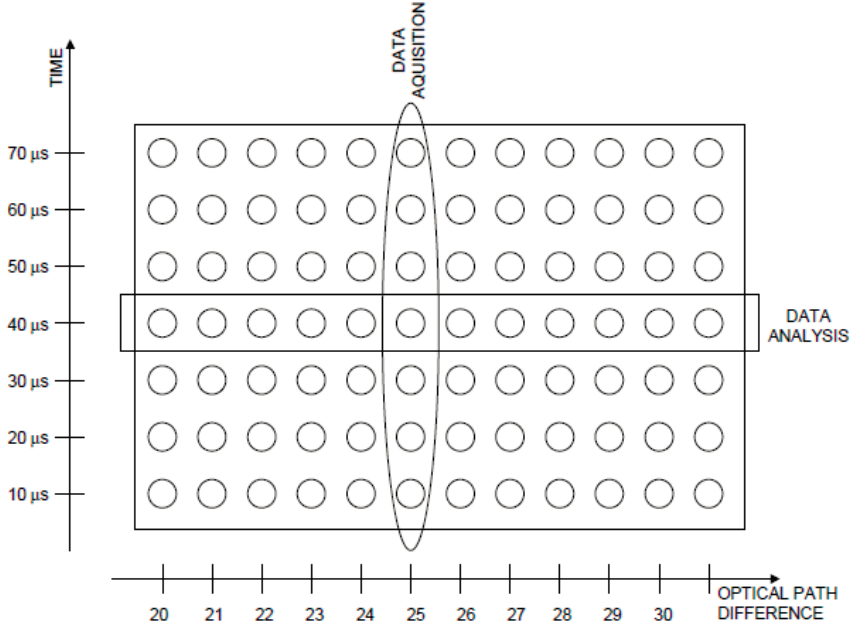
Figure 4. Data array in a time-resolved step-scan FTIR experiment. Data are collected in columns (one column corresponds to each mirror position) and analyzed in rows (each row corresponds to a given time after the